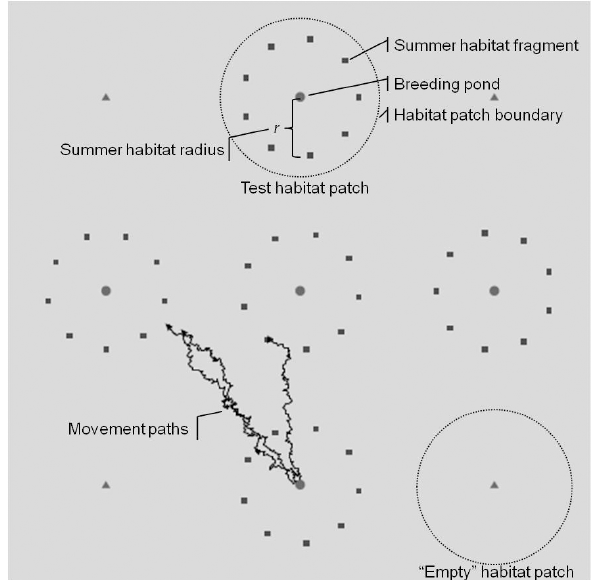
Figure 1. Model landscape with nine habitat patches. The model landscape contains five test (habitat) patches and four empty (habi- tat) patches (see text). Each test habitat patch is defined by a central breeding pond and fragments of summer habitat within the habitat patch boundary. Distance between breeding pond and summer habi- tat is denoted r . Black sinuous lines are examples of the movement paths of three di ff erent frog